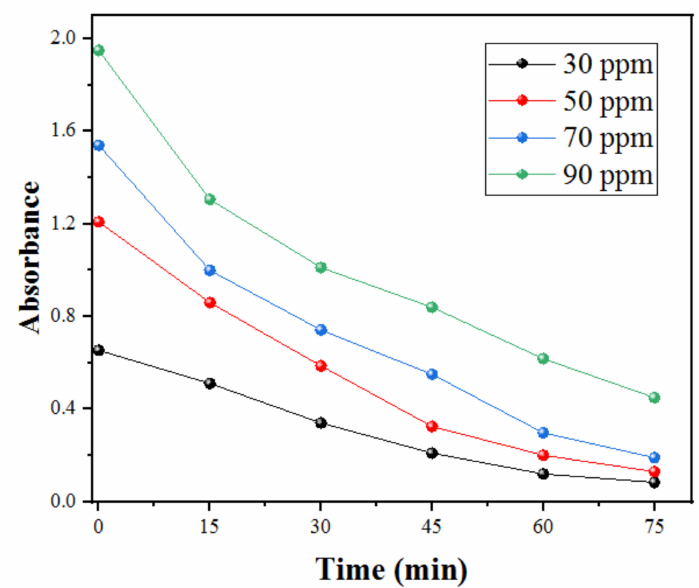
Figure 12. Effect of variation of the initial concentration of SDB on the sonophotocatalytic degradation under optimum conditions (15 mL of SDB, pH 6, 75 min irradiation, 40 mg Qds).